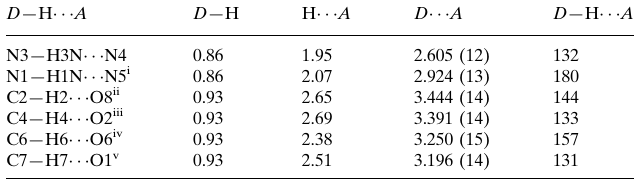
Hydrogen-bond geometry (A˚ , (cid:2)